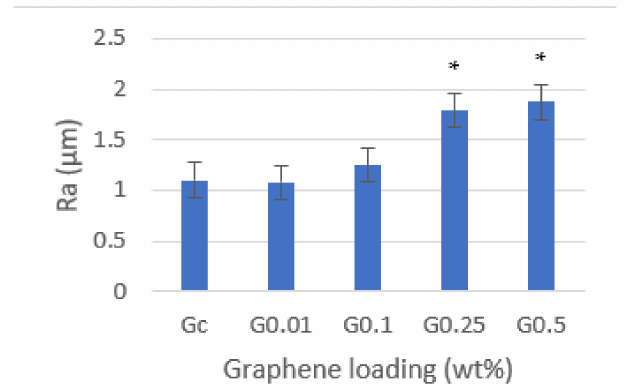
Figure 5. Effect of graphene on PMMA resin’s surface roughness. Mean results ( ± standard deviation) are presented as Ra ( µ m) measured using contact profilometer. Asterisks (*) indicate statistical significance compared to Gc ( p < 0.05).